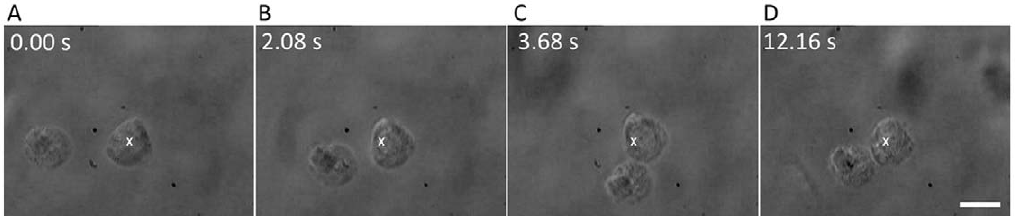
Figure 5. Time-lapse images of membrane-mediated cell adhesion dynamics. A) – C) Time lapse images from a real-time movie (Movie S2) showing surface adhesion of two neural progenitor cells without filopodia. The white cross denotes the position of the optically-trapped cell being brought towards the second cell. Irreversible adhesion occurs after the two cells are in contact by their surface membranes for about 5 seconds. The scale bar denotes 10 m